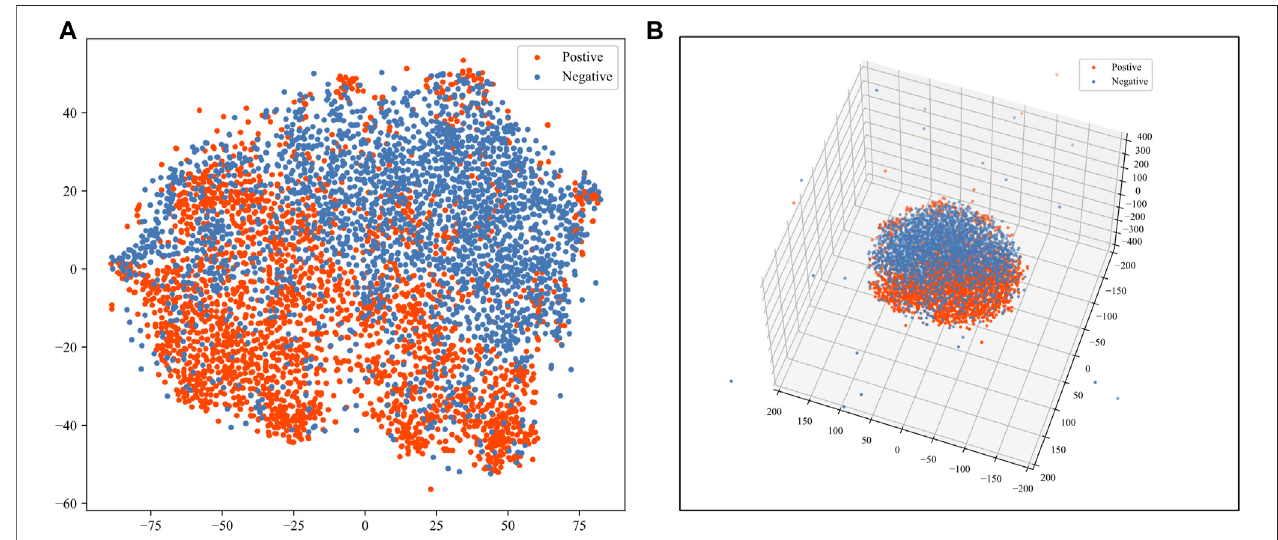
FIGURE 5 | Visualization of sequence features. The red dots represent the positive samples. The blue dots represent the negative samples. (A) Visualization of 2- dimensional t-SNE. (B) Visualization of 3-dimensional t-SNE.